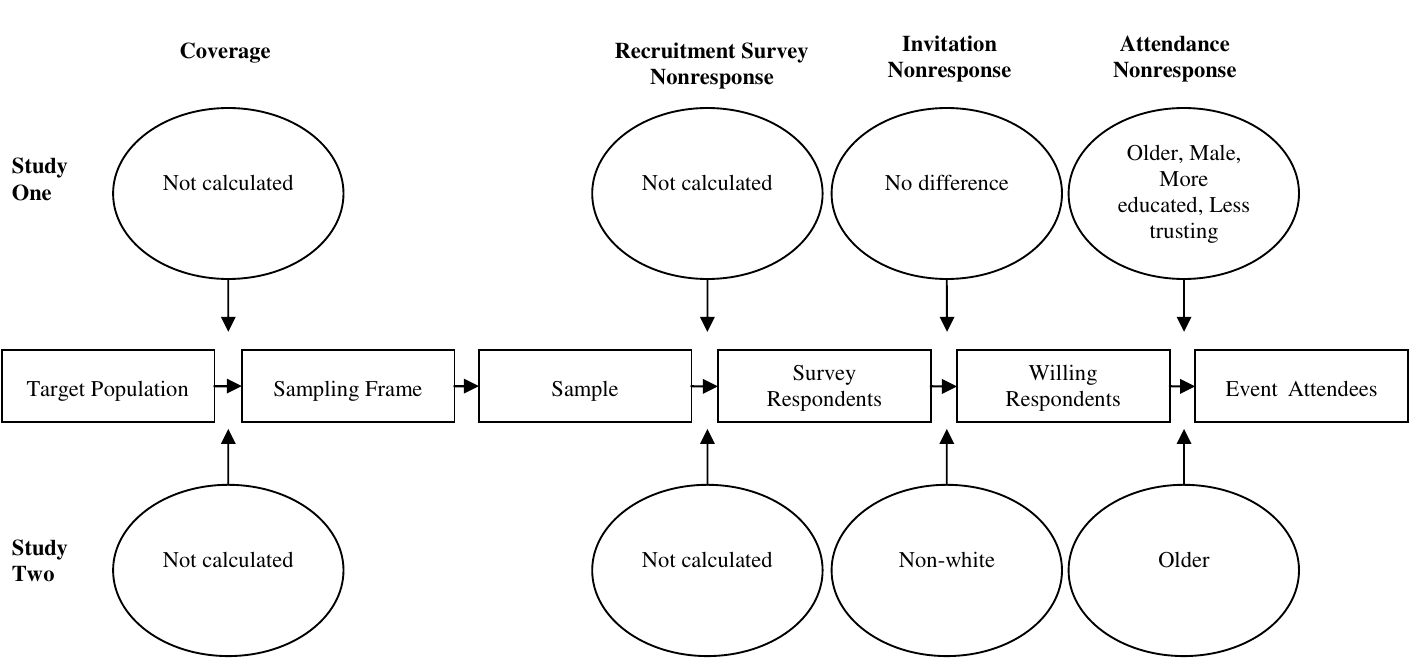
Figure 3. Summary of coverage and nonresponse